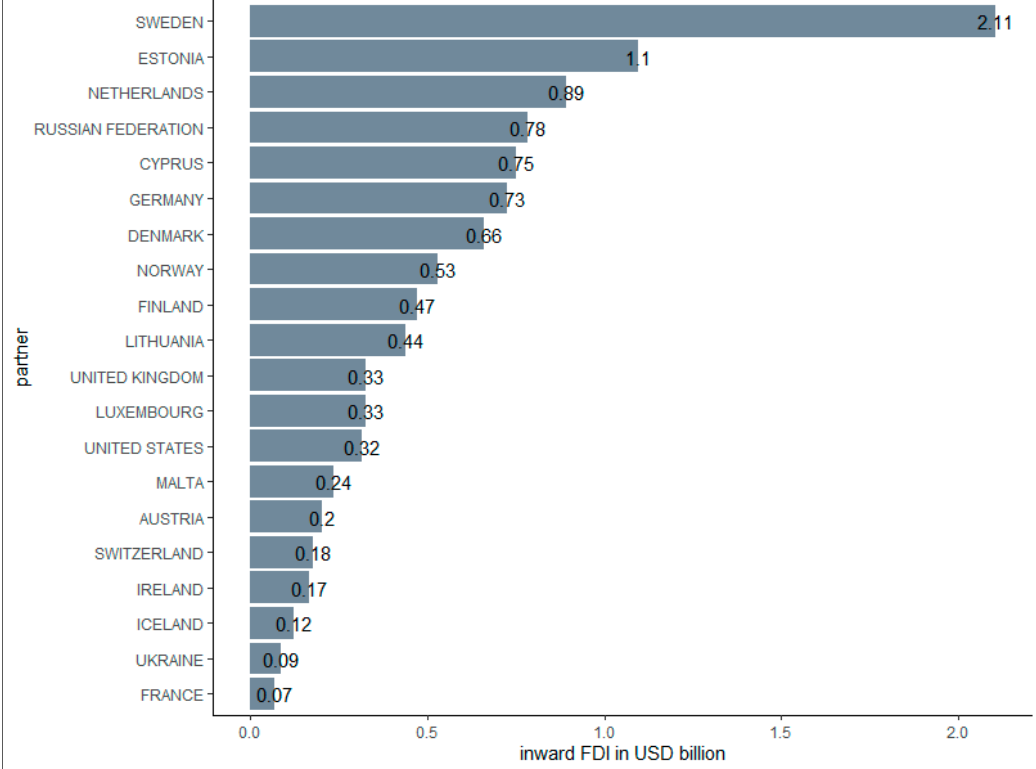
Figure A3. Average inward FDI stocks in economic sectors of Latvia across 2004–2017.